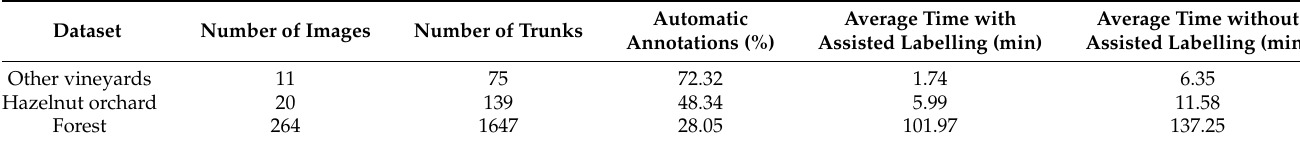
Table 6. Assisted labelling procedure